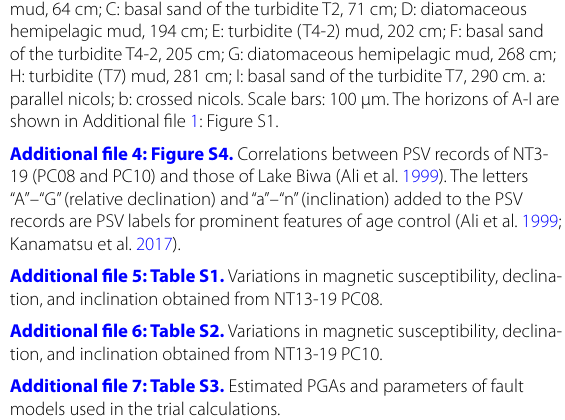
Additional file 4: Figure S4. Correlations between PSV records of NT3- 19 (PC08 and PC10) and those of Lake Biwa (Ali et al. 1999). The letters “A”–“G” (relative declination) and “a”–“n” (inclination) added to the PSV records are PSV labels for prominent features of age control (Ali et al. 1999; Kanamatsu et al.